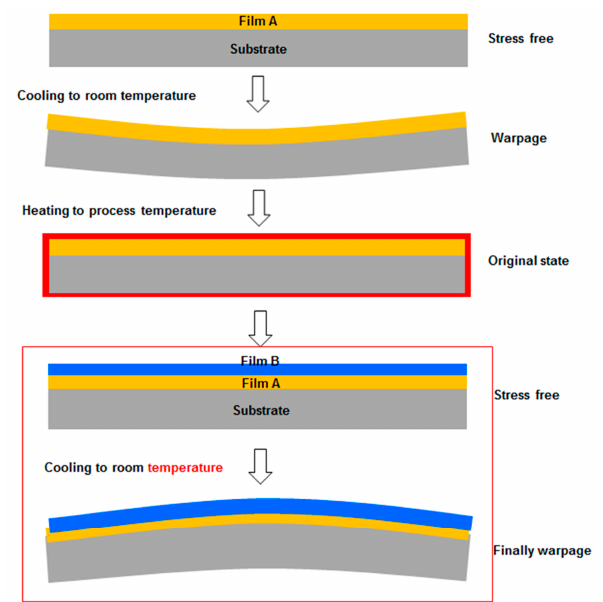
Figure 4. Schematic of the film-stacking process. Each film is annealed before stacking and films are stacked from the bottom up.